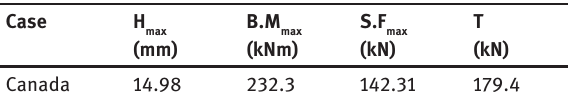
Table 9: Results of analysis with Canadian codes. Case